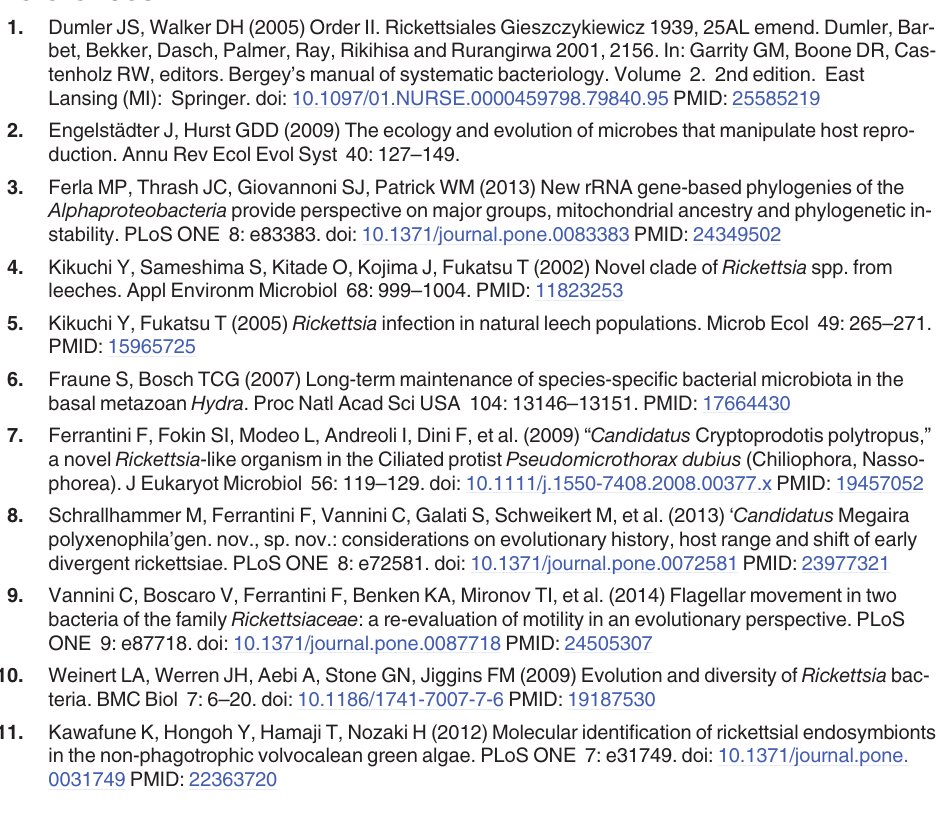
S2 Table. The list of primers used in genomic PCR, semi-quantitative genomic PCR and se- quencing of this study. S3 Table. List of Volvox carteri and other algal strains used in this study. DDBJ/EMBL/Gen- Bank accession numbers of nuclear ribosomal DNA internal transcribed spacer regions and rickettsial gene-like sequences determined in this study are also shown. S4 Table. DDBJ/EMBL/GenBank accession numbers of the rickettsial murB and ddlB genes/gene-like sequences used in this